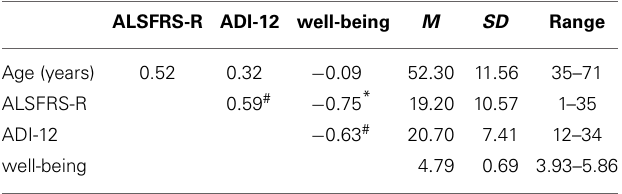
Table 1 | Patients’